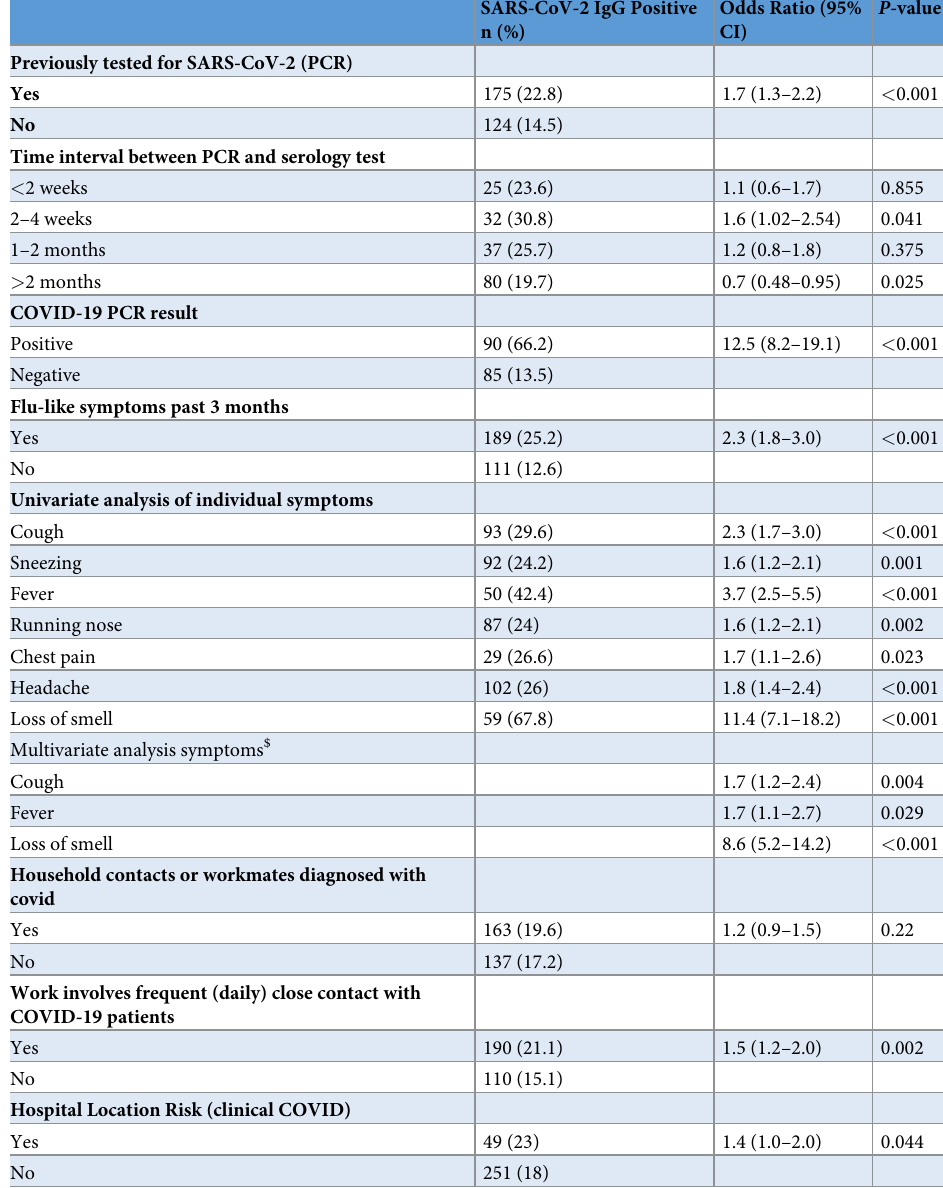
Table 3. Risk factors for a positive anti-nucleocapsid IgG